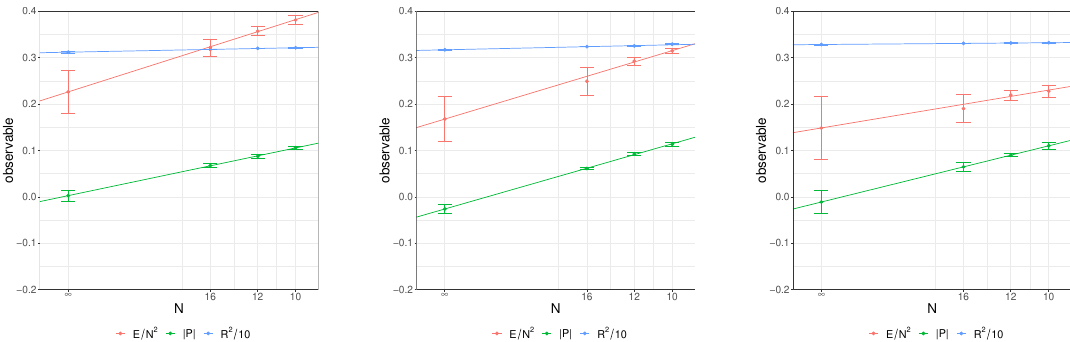
Figure 29. Full BFSS (i.e., full BMN with µ = 0 ) at temperature T = 0 . 2 . From left to right: large N extrapolation for lattice size L = 30 , 36 and 48 . The horizontal axis scales 27 as 1 /N . We can see that the large- N extrapolation of the Polyakov loop is very close to zero for all values of L . As a result, the Polyakov loop is consistent with zero in the simultaneous continuum and large- N limits. We again refer to appendix F for the datapoint with L = 30 , N = 16